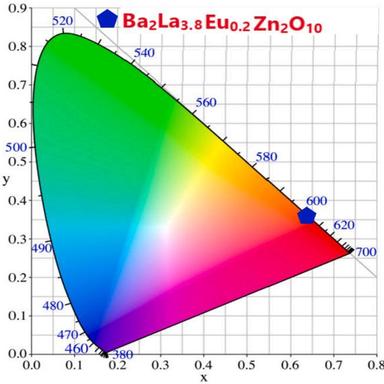
CIE chromaticity diagram with color coordinates of the optimized nanophosphor Ba2La3.8Eu0.2Zn2O10.